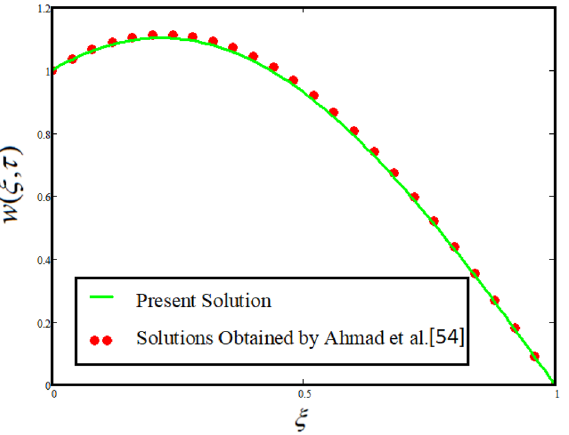
Figure 16. Comparison between the present solutions and Ahmad et al. 54 when τ = 1 , φ hnf = 0 , Pr = 21 , Gr = 4 , G = 0 , (cid:31) = 3 , α = 0.5 and Re = 1.2 .